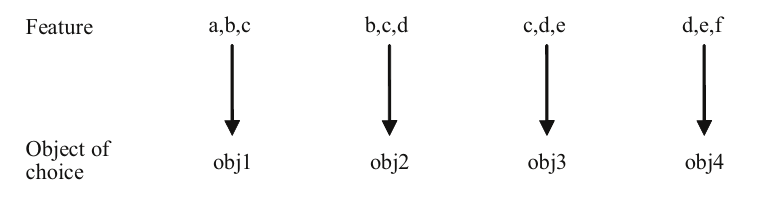
Fig. 2. Schema of identi fi cation of cultural objects (Bowen, Petersen